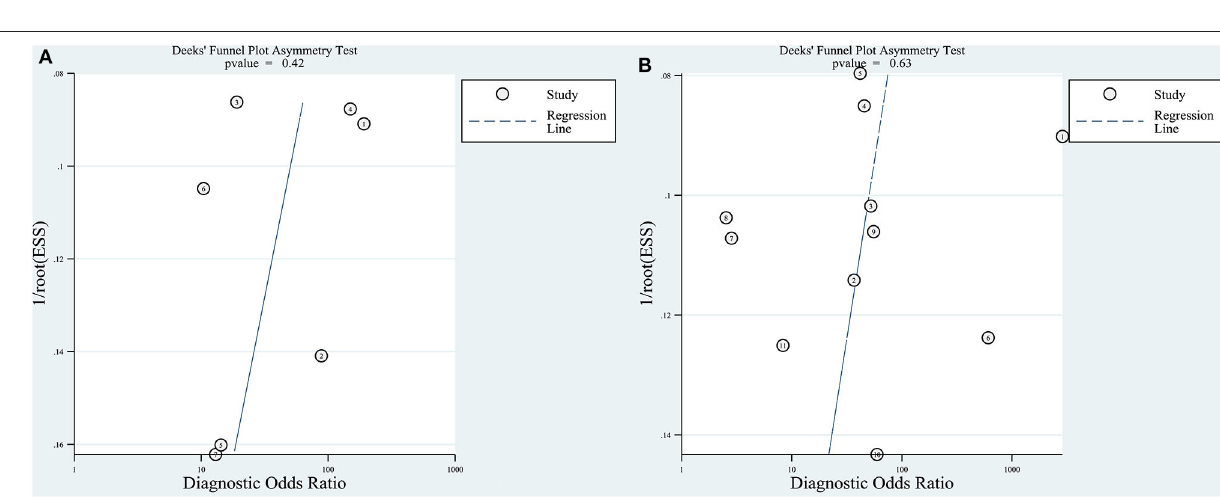
FIGURE 4 | Deeks’ funnel plot asymmetry test for testing publication bias. Publication bias was assessed by testing the asymmetry of Deeks’ funnel plot [the inverse of the square root of the effective sample size (1/rootESS) vs. the natural logarithm of the DOR (lnDOR)]. P < 0.05 for the slope coefficient indicates significant asymmetry, i.e., significant publication bias. (A) Quantitative elastography studies; (B) qualitative elastography